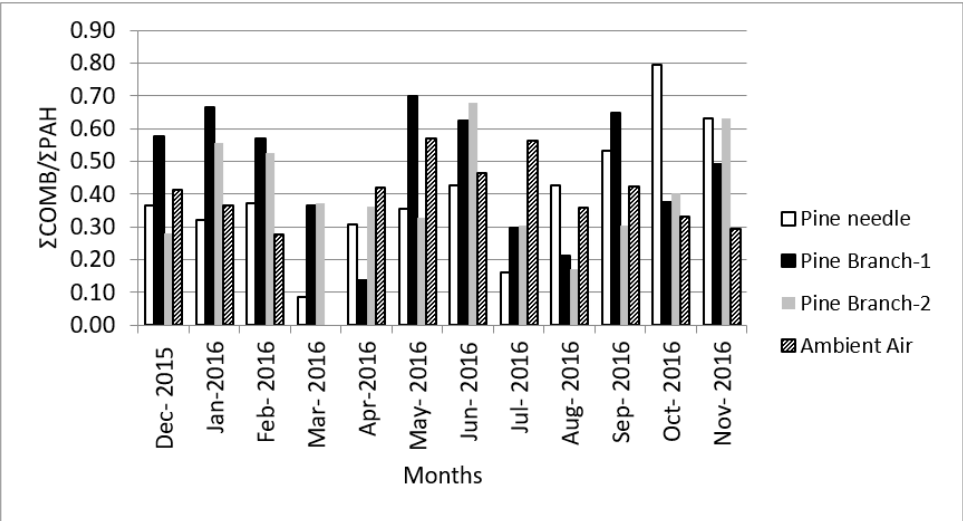
Figure 6. Σ COMB/ Σ PAHs ratios for the tree components and ambient air. Note: Pine branch-1 and Pine branch-2 refer to 1-year-old and 2-year-old branches.